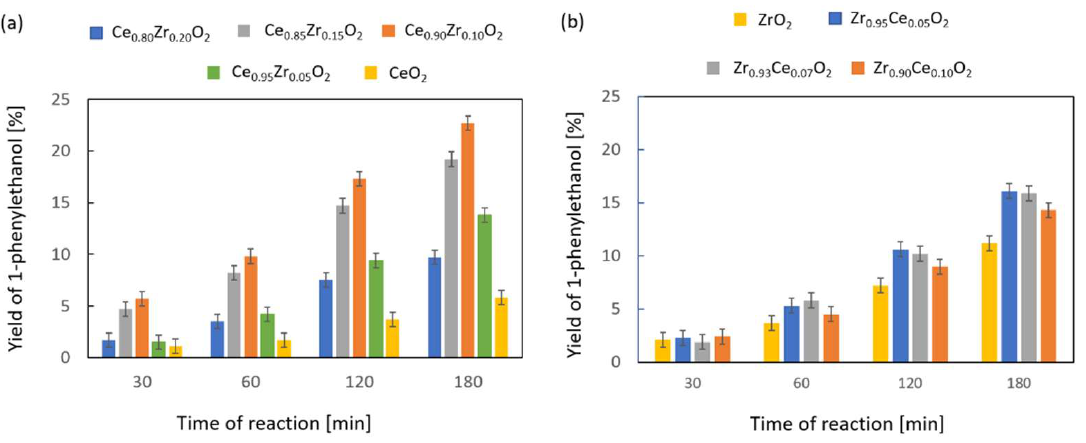
Figure 2. Yield of 1-phenylethanol obtained during catalytic transfer hydrogenation of acetophenone with 2-pentanol in the presence of ( a ) Ce 1−x Zr x O 2 (x < 0.2) and ( b ) Zr 1−x Ce x O 2 (x < 0.1).